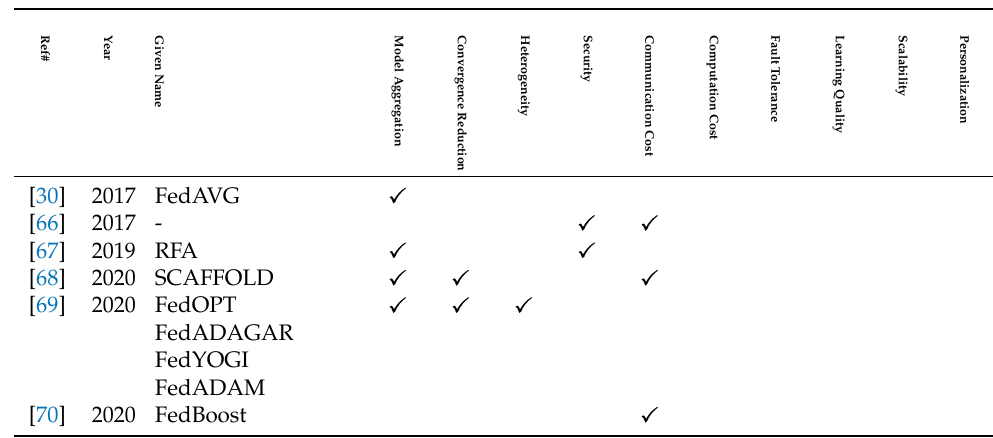
Table 3. Contributions of existing FL aggregation